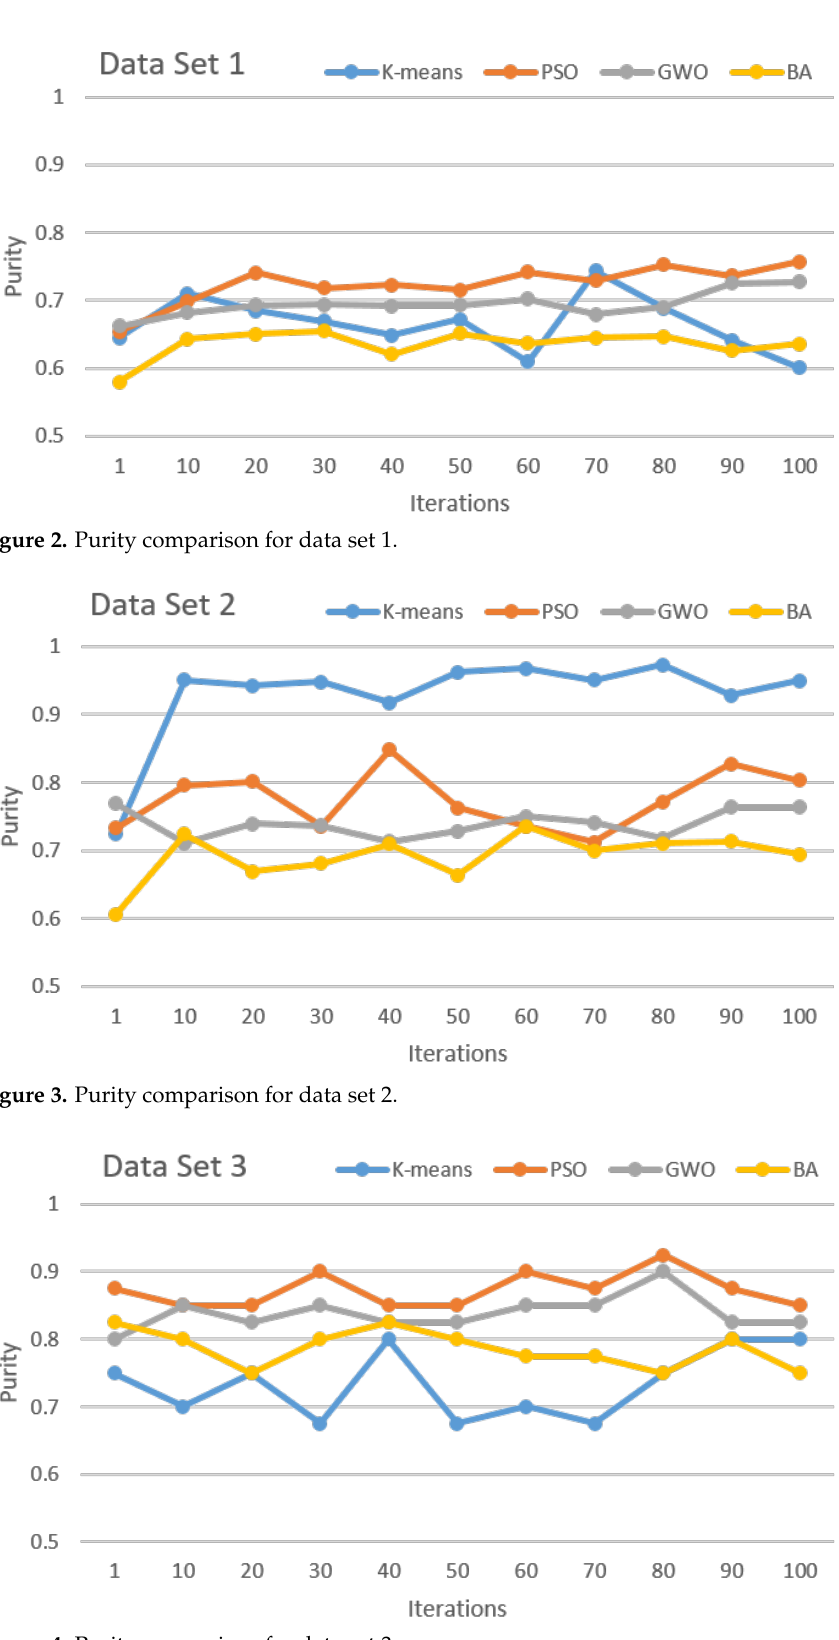
Figure 4. Purity comparison for data set